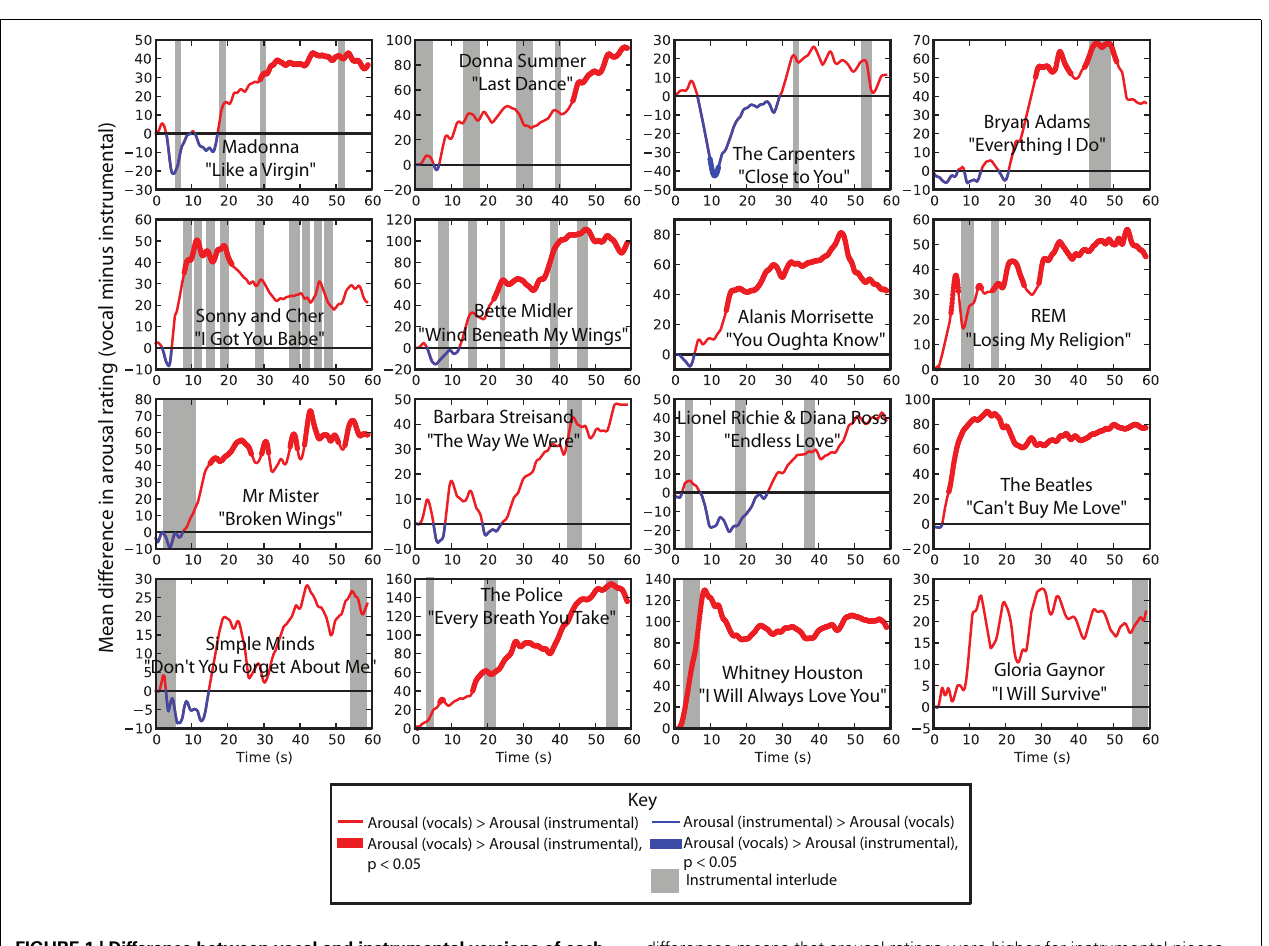
FIGURE 1 | Difference between vocal and instrumental versions of each song over time. Positive difference means that arousal ratings for vocal pieces were higher than for their instrumental counterparts; negative